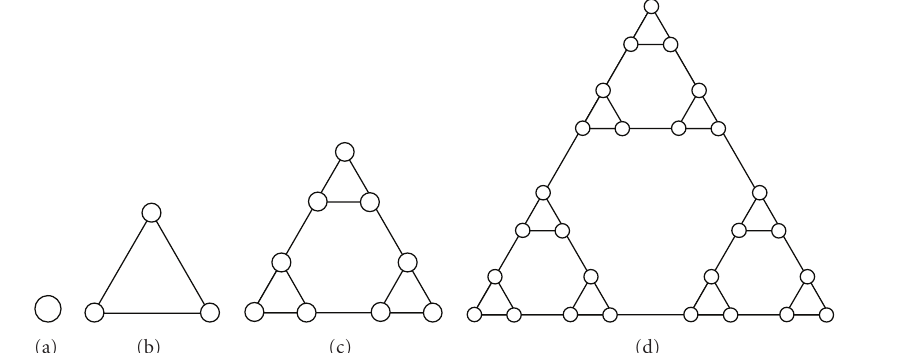
Figure 17: A 64 Node FTBB-based HIN [14].